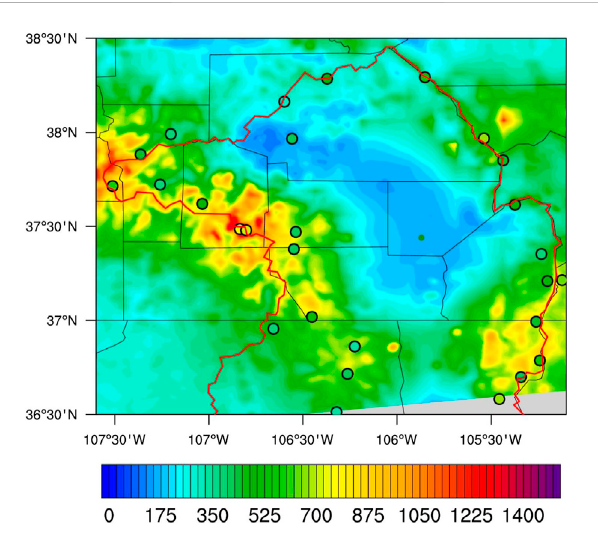
FIGURE 2 NLDAS 2021 precipitation totals (mm), overlaid with SNOTEL 2021 precipitation totals ( fi lled circles). The boundary of the upper Rio Grande basin is outlined in